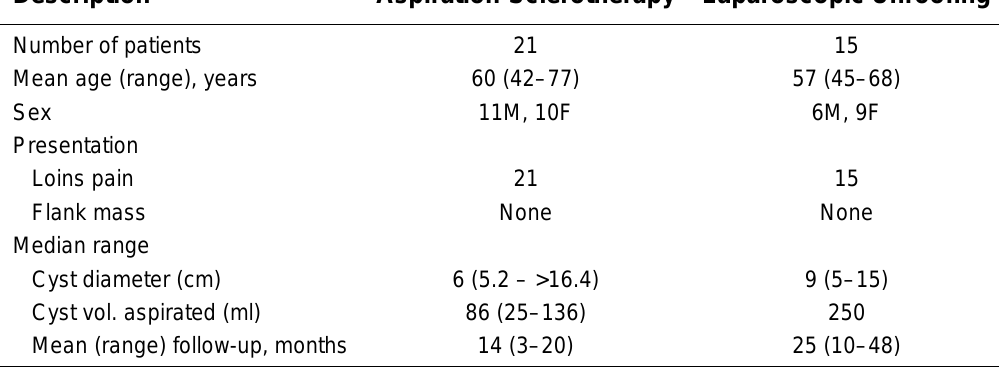
Comparison of Aspiration-Sclerotherapy and Laparoscopic Unroofing Applied Patient